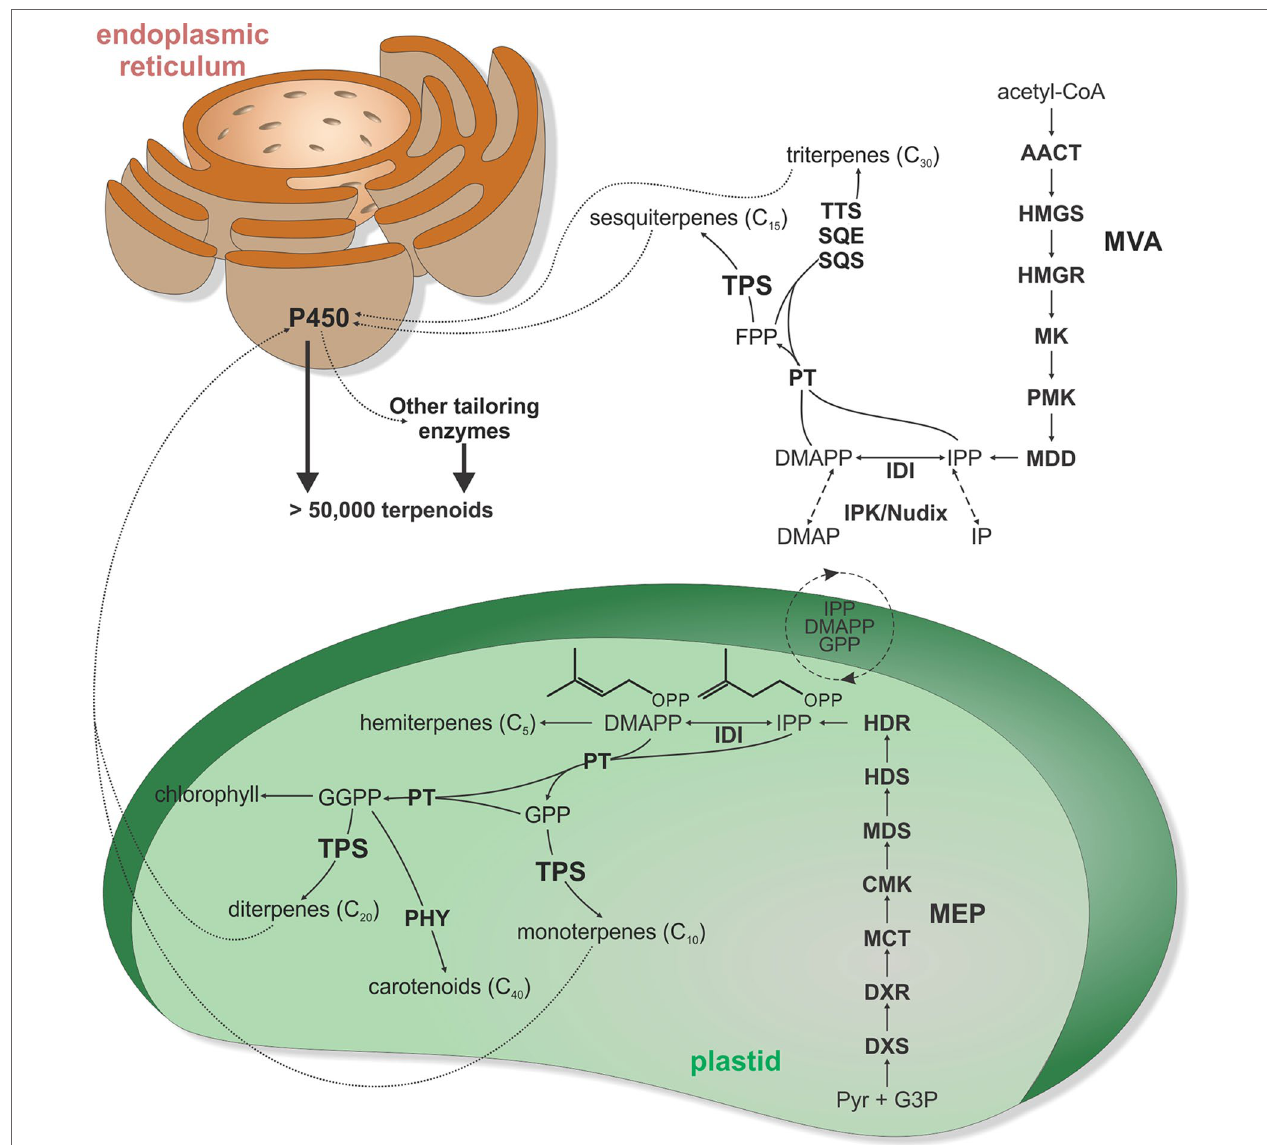
FIGURE 1 | Schematic overview of major terpenoid biosynthetic pathways. All terpenoids are derived from two isomeric 5-carbon precursors, isopentenyl diphosphate (IPP), and dimethylallyl diphosphate (DMAPP). In turn, IPP and DMAPP are formed via two pathways, the cytosolic mevalonate (MVA) pathway originating from acetyl-CoA and the pyruvate and glyceraldehyde-3-phosphate (G3P)–derived 2-C-methyl-D-erythritol-4-phosphate (MEP) pathway located in the plastids. However, active transfers of IPP, DMAPP, GPP, and FPP across the plastidial membrane enable some degree of pathway cross-talk. In addition, interconversion of IPP and DMAPP with their respective monophosphate forms IP and DMAP by IP kinase (IPK) and Nudix hydrolase enzymes can impact pathway flux in terpenoid metabolism. Except for isoprene and hemiterpene (C 5 ) biosynthesis, condensation of IPP and DMAPP units generates prenyl diphosphate intermediates of different chain length. Condensation of IPP and DMAPP yields geranyl diphosphate (GPP) as the precursor to monoterpenoids (C 10 ), fusing GPP with an additional IPP affords the sesquiterpenoid (C 15 ) precursor farnesyl diphosphate (FPP), and fusing FPP with IPP generates geranylgeranyl diphosphate (GGPP) en route to diterpenoids (C 20 ). Furthermore, condensation of two FPP or two GGPP molecules forms the central substrates of triterpenoid (C 30 ) and carotenoids (C 40 ), respectively. Terpene synthases (TPS) are key gatekeepers in the biosynthesis of C 10 –C 20 terpenoids, catalyzing the committed scaffold-forming conversion of the respective prenyl diphosphate substrates into a range of hydrocarbon or oxygenated structures. These TPS products can then undergo various oxygenations through the activity of cytochrome P450 monooxygenases (P450), followed by further possible functional decorations, ultimately giving rise to more than 80,000 distinct natural products. AACT, acetoacetyl-CoA thiolase; CMK, 4-diphosphocytidyl-2-C-methyl-D-erythritol kinase; DXR, 1-deoxy-D-xylulose 5-phosphate reductase; DXS, 1-deoxy-D-xylulose 5-phosphate synthase; HDR, (E)-4-hydroxy-3-methyl-but-2-enyl diphosphate reductase; HDS, (E)-4-hydroxy-3- methyl-but-2-enyl diphosphate synthase; HMGR, 3-hydroxy-3-methylglutaryl-CoA reductase; HMGS, 3-hydroxy-3-methylglutaryl-CoA synthase; IDI, isopentenyl diphosphate isomerase; MCT, MEP cytidyltransferase; MDD, mevalonate-5-diphosphate decarboxylase; MDS, 2-C-methyl-D-erythritol 2,4-cyclodiphosphate synthase; MK, mevalonate kinase; P450, cytochrome P450-dependent monooxygenase; PHY, phytoene synthase; PMK, phosphomevalonate kinase; PT, prenyl transferase; SCS, squalene synthase; SQE, squalene epoxidase; TPS, terpene synthase; TTS, triterpene